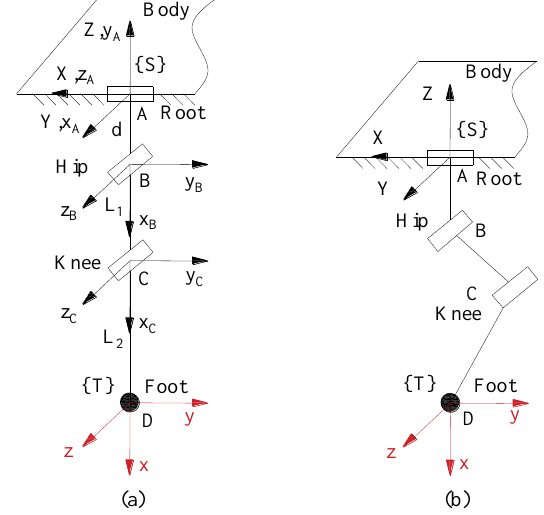
Figure 4. Leg posture and coordinate frames: ( a ) initial posture; ( b ) general posture.